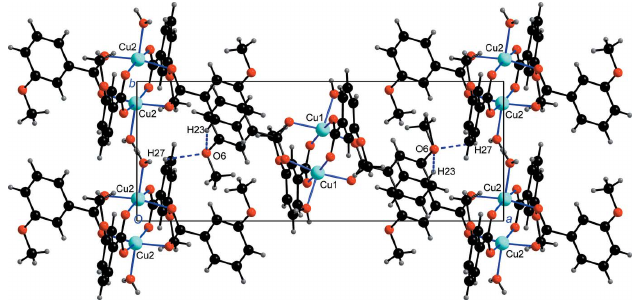
Figure 3 A view along [001] showing the interlinking of dimeric Cu1 units with adjacent dimeric Cu2 units with the aid of C—H (cid:2)(cid:2)(cid:2) O hydrogen bonds.